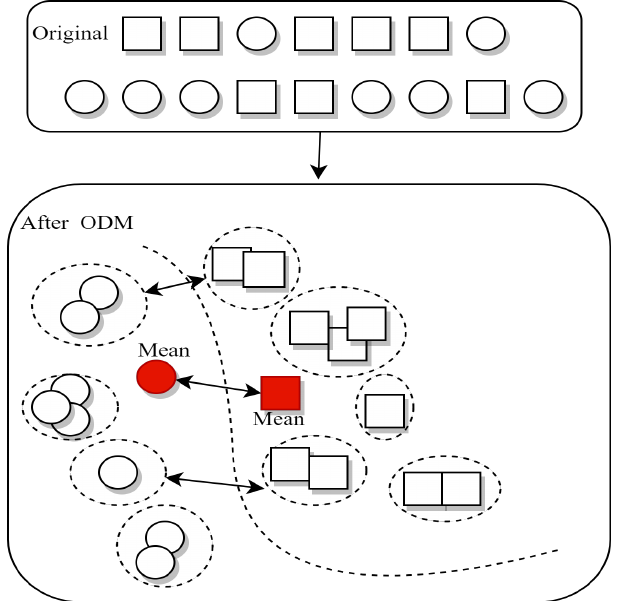
Figure 5. Illustration of the effect of ordered